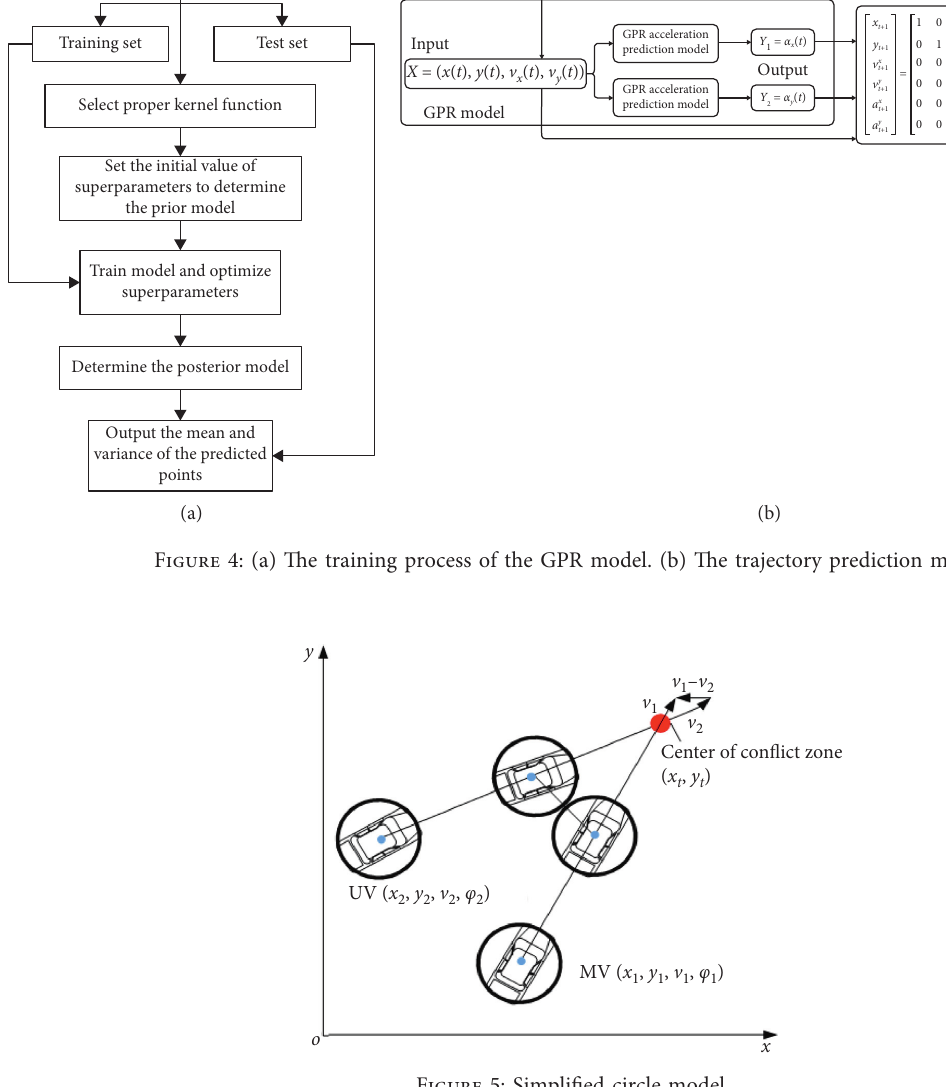
Figure 5: Simplified circle